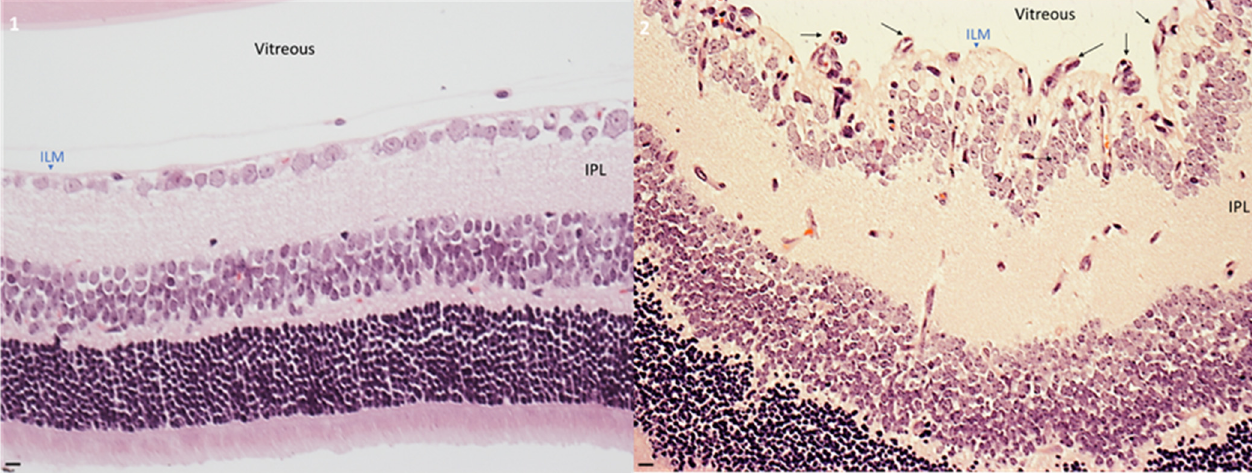
Figure 1. Hyperoxia exposure induces pathological angiogenesis generating a proliferative retinopathy model. Micrographs of retinal histological slides using H&E staining. ( 1 ) Normoxia exposure developed a physiological angiogenesis in pups at P18. Retinal morphology was normal, no pathological angiogenesis was observed. ( 2 ) Hyperoxia condition developed pathological angiogenesis located at the superficial retina with a disorganized distribution. Black arrows indicate the neovascular formation at the inner limiting membrane. Representative micrographs of 2 independent assays ( n = 5 of each assay). Bars = 20 µ